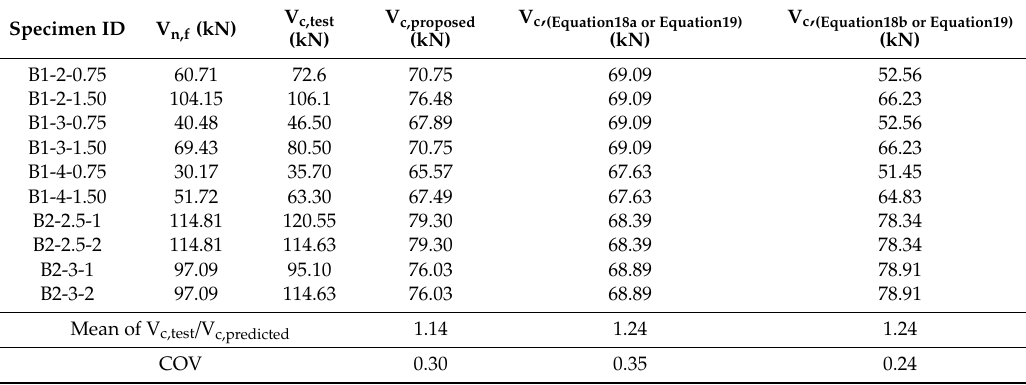
Figure 10. Comparison between experimental and proposed prediction results (Equation (17)). Table 7. Comparison between measured and predicted strengths.